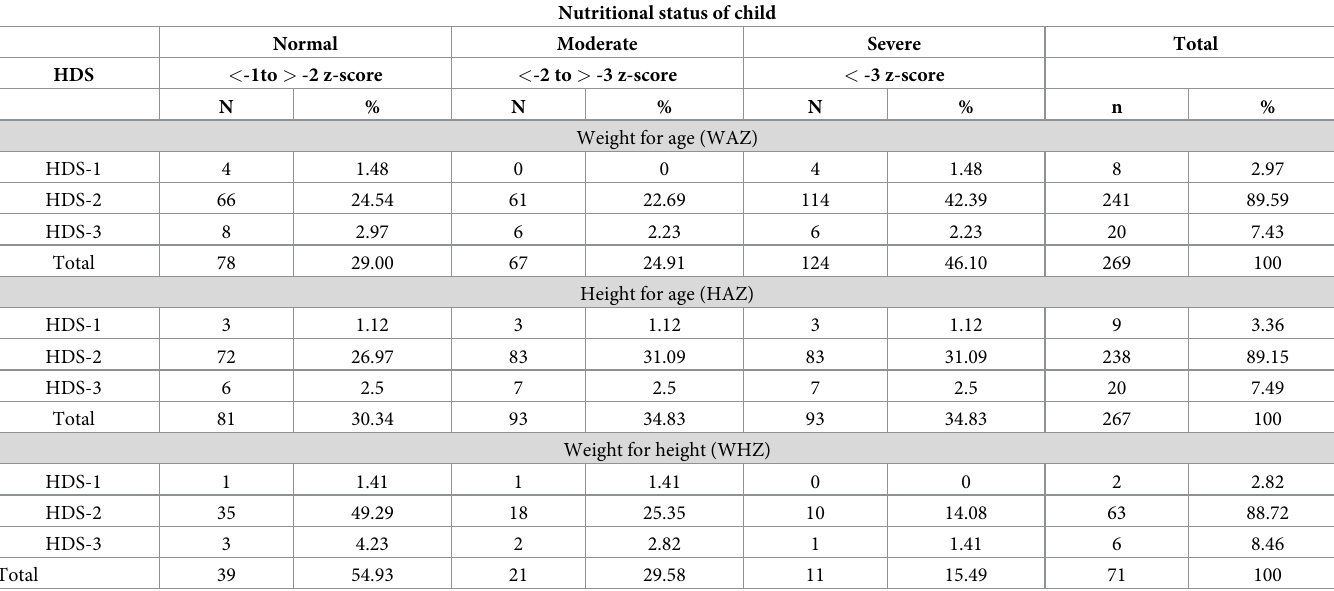
Table 4. Association among child nutrition and HDS.